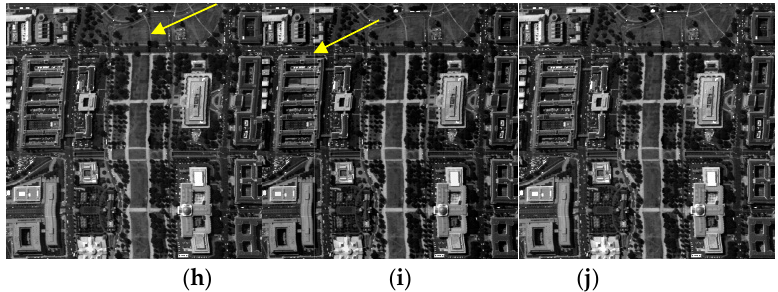
Figure 6. Destriping results of band 5 for the non-periodic stripes case (r = 0.4 and I = 60): ( a ) original,